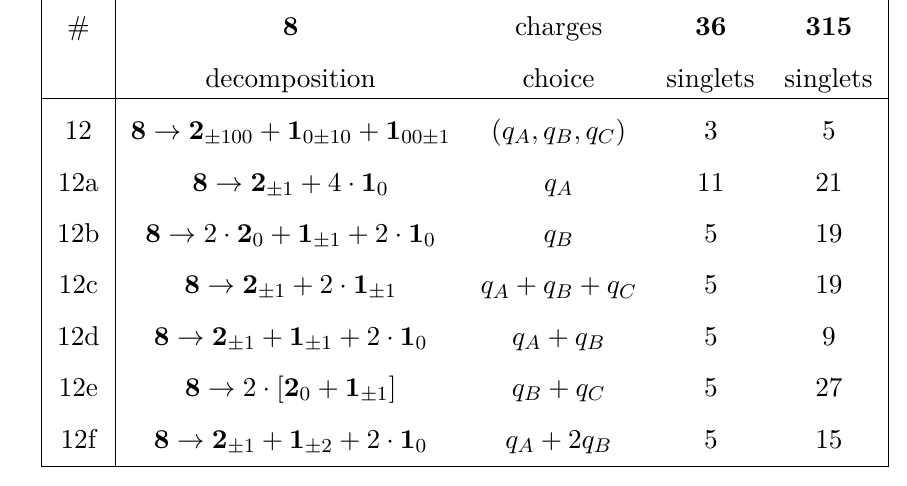
Table 5 . Branchings for the case 12.